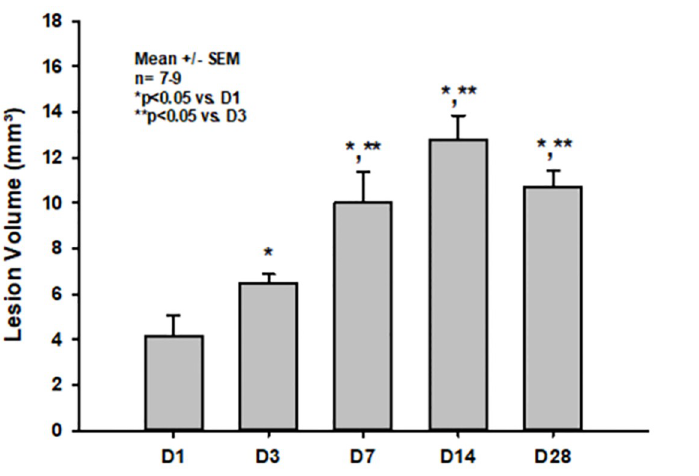
Fig 3. Lesion volume on days one thru 28 after